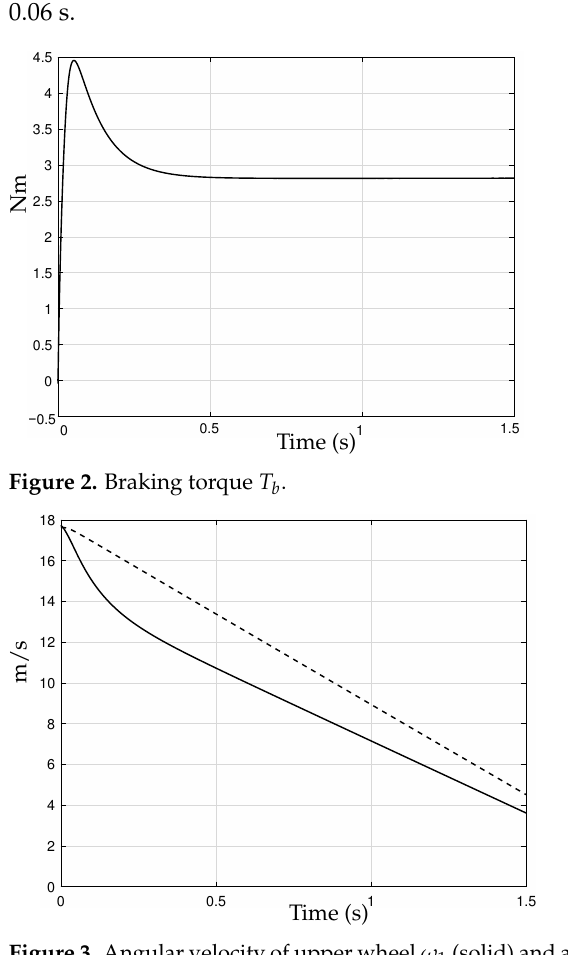
Figure 3. Angular velocity of upper wheel ω 1 (solid) and angular velocity of lower wheel ω 2